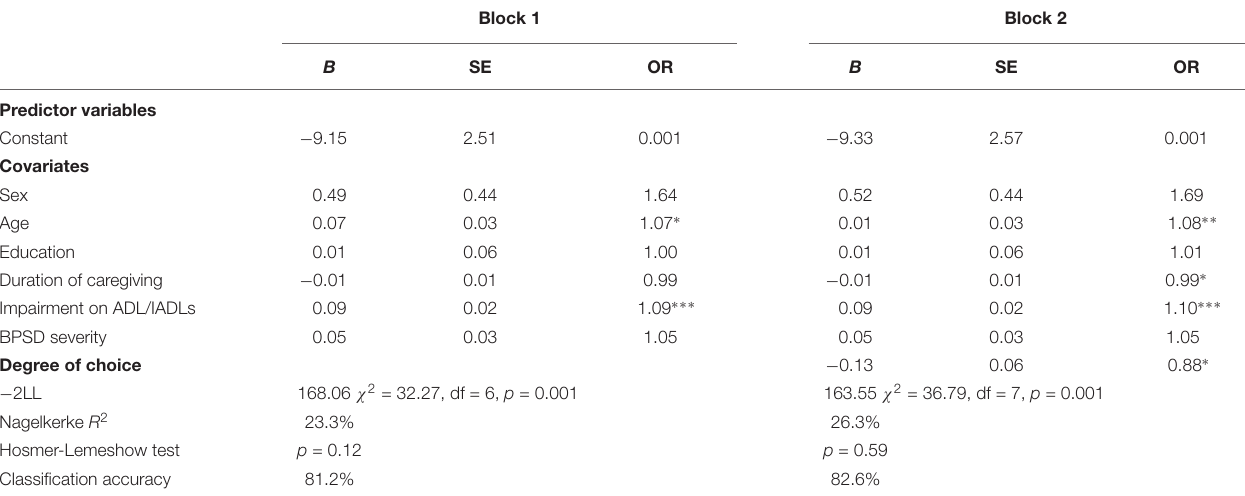
TABLE 2 | Logistic regression of degree of caregiver choice at baseline and placement in LTC at